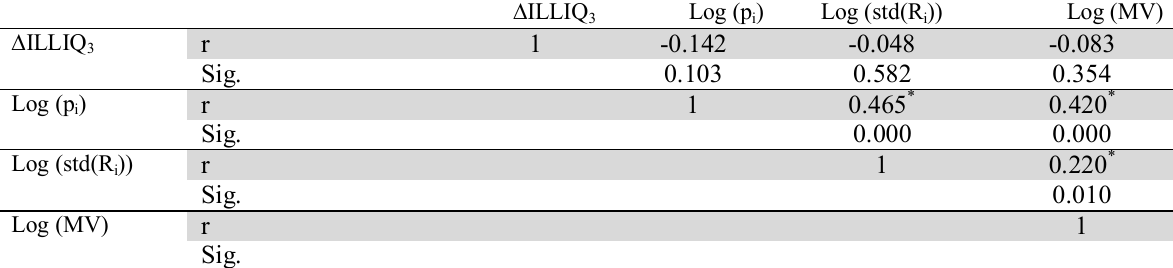
The summary of Pearson correlation ratios for variables associated with the third